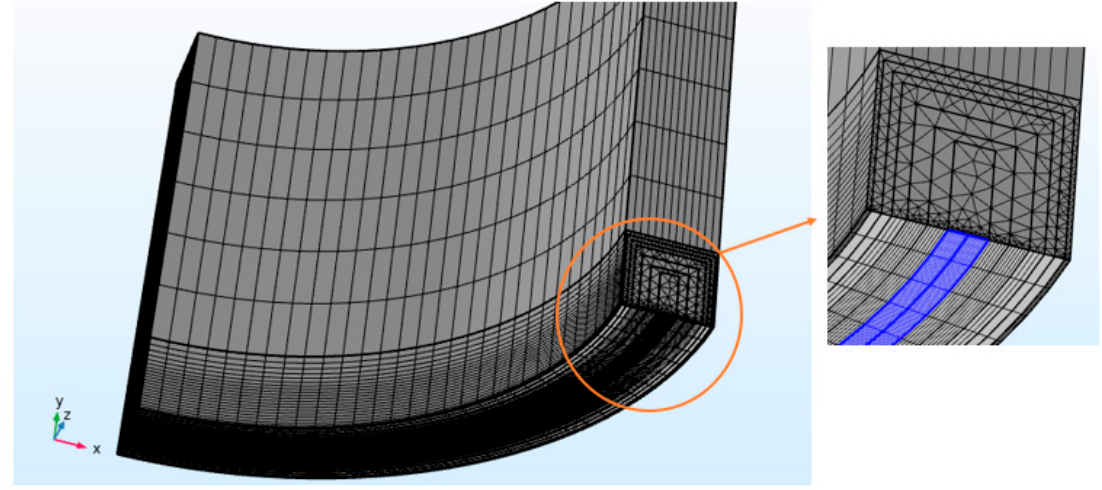
Figure 4. Finite element mesh for 1 / 8 cracked pipe showing mesh refinement in the crack region.